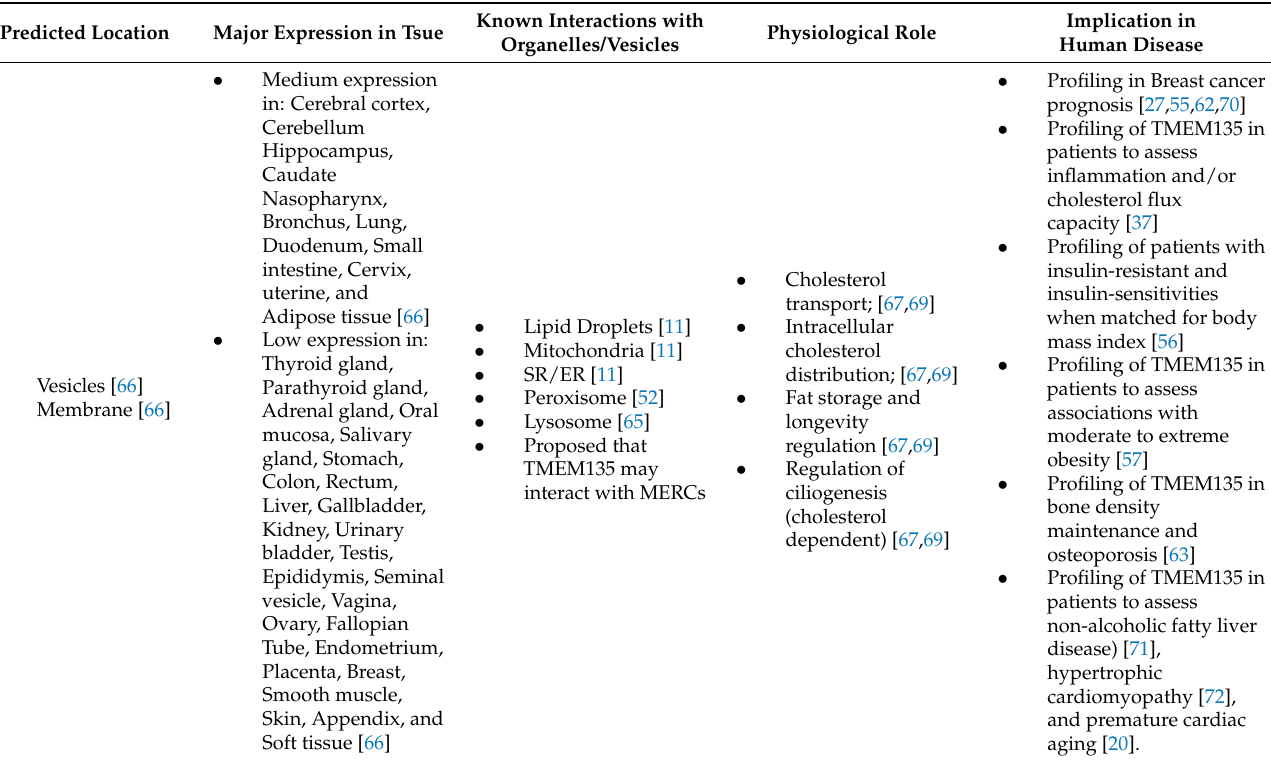
Table 1. TMEM135 has many implications in disease and many potential physiological roles. Using The Human Protein Atlas Databank [67] and literature, we show the predicted locations of TMEM135, expression in human tissue, known interactions with organelles and vesicles, the physiological role of TMEM135 [68], and the implication of TMEM135 in human disease. Predicted